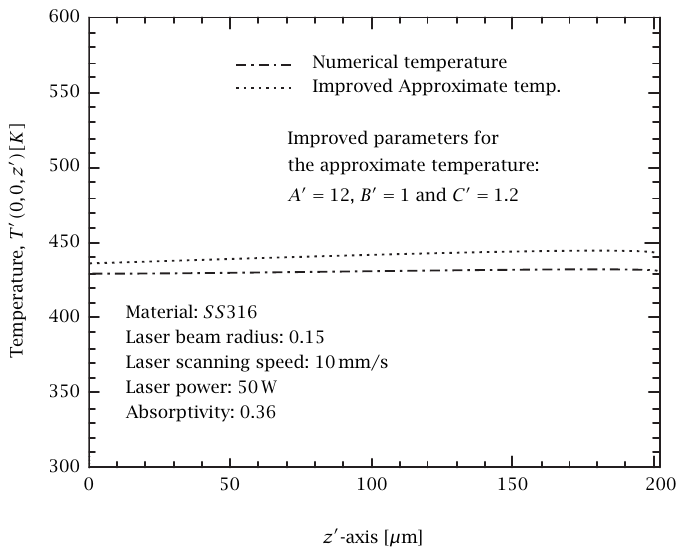
Figure 2.7 . Comparison between the numerical and improved approximate temperatures ( r = 0 . 75mm case).